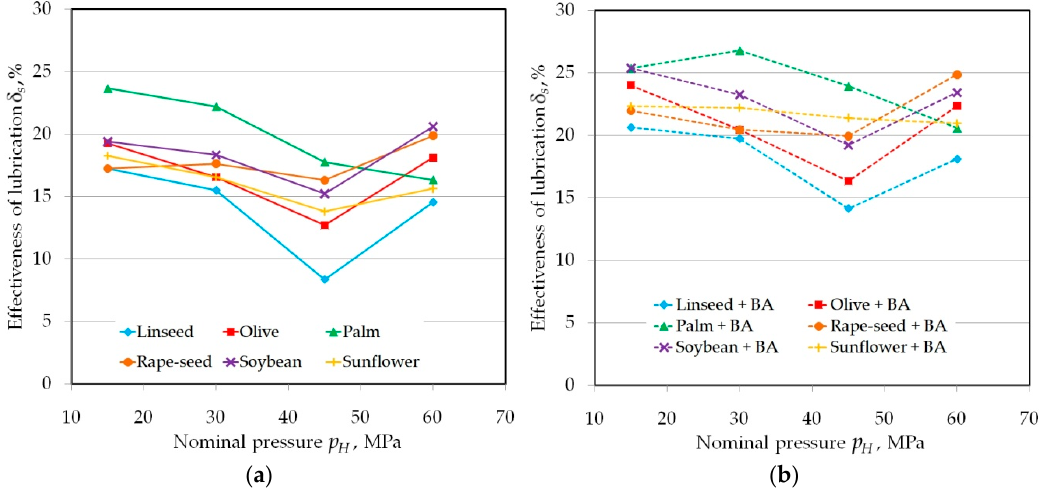
Figure 7. The effectiveness of lubrication using ( a ) pure vegetable oils and ( b ) vegetable oils with added BA in tests carried out under a range of nominal pressure between 15 and 60 MPa for a roll roughness of Ra = 0.32